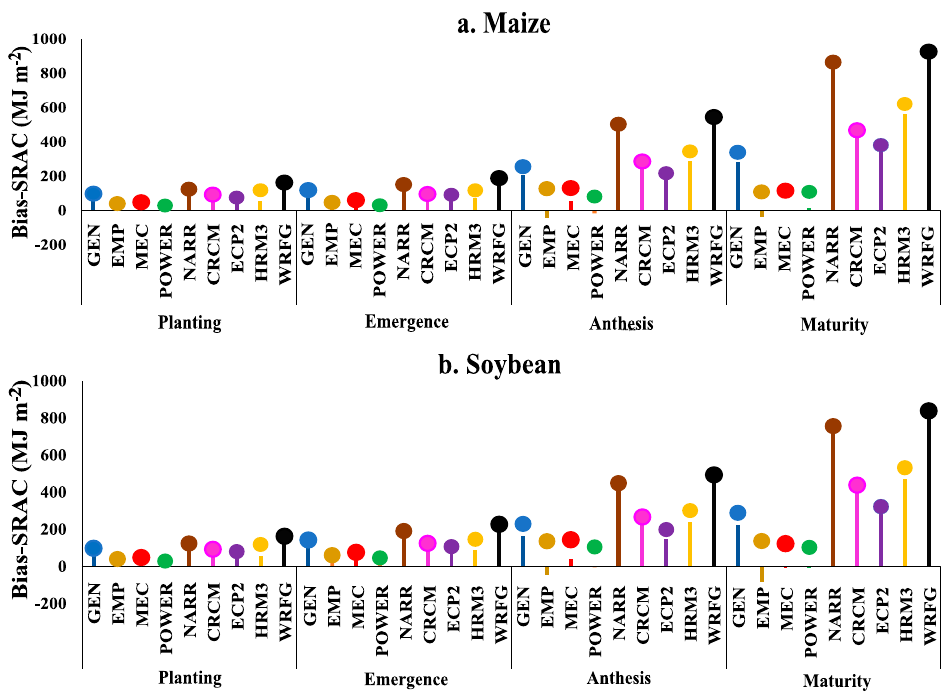
Figure 4. Root mean squared error (RMSE, colored circles) and mean error (ME, colored bars) of accumulated daily solar radiation (SRAC) for the different sources of estimated solar radiation at the start date of planting, emergence, anthesis, and maturity for maize ( a ) and soybean ( b ). See Figure 2 for definition of abbreviations.